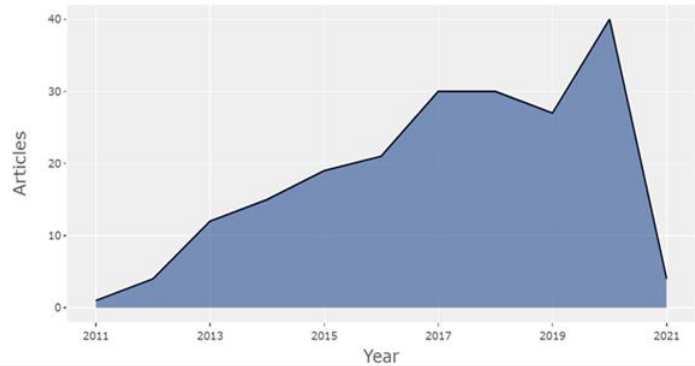
Figure 5. Number of publications in Dataset 1 per year.